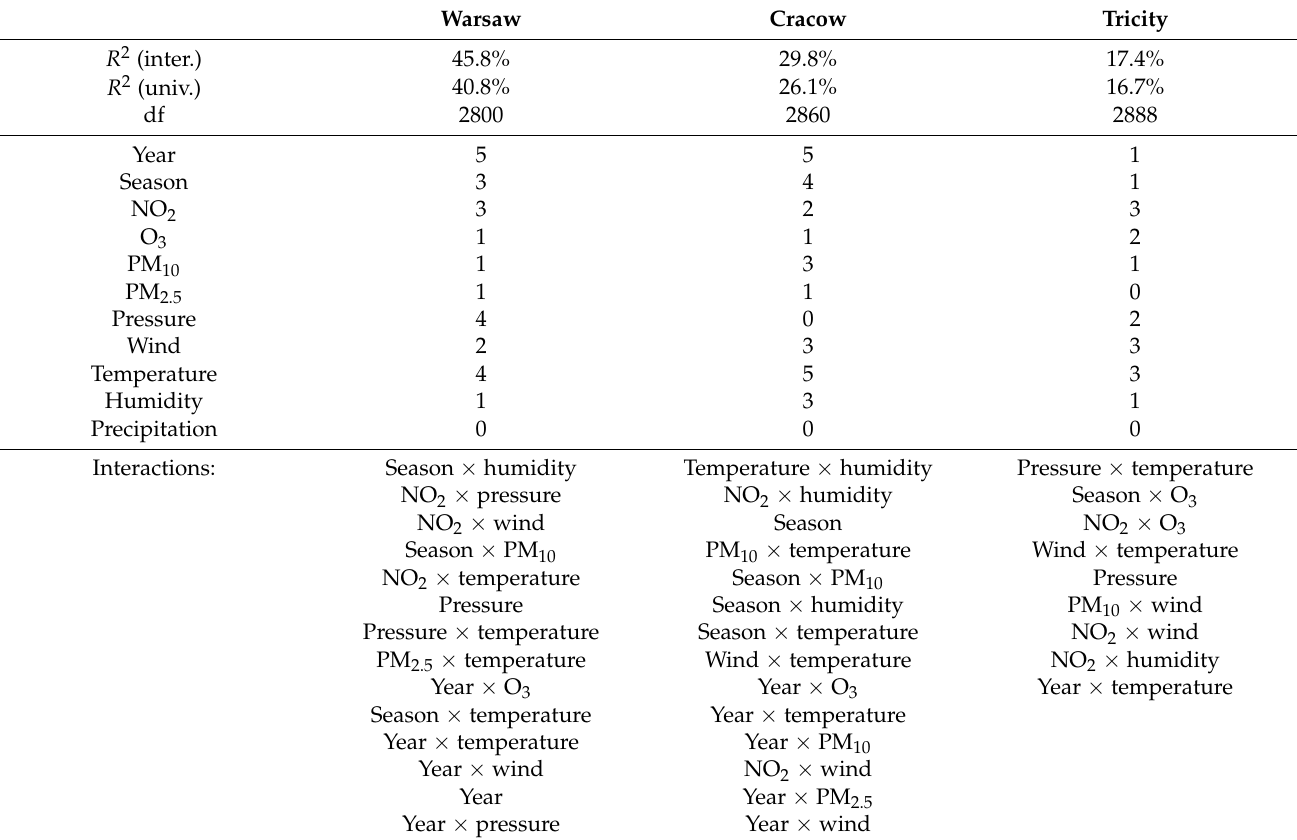
Table 4. Characteristics of the final models (with and without interactions) describing effects of air pollutants and weather conditions on the number of pneumonia-related hospitalizations. Warsaw Cracow Tricity R 2 (inter.) R 2